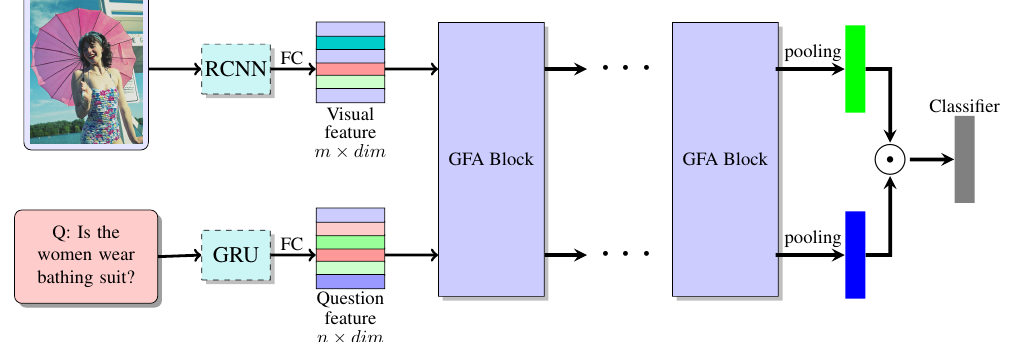
Figure 1. Illustration of the multi-modality global fusion attention network (MGFAN) with the GFA block.